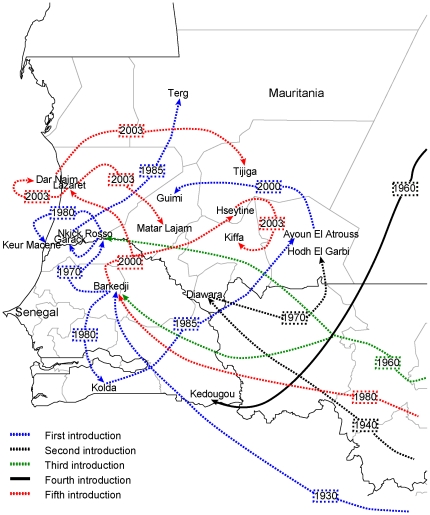
Geographic spread of RVFV in Mauritania and Senegal.The directed lines connect the sources and target localities (shown by arrows) of viral lineages. The distinct introductions into Senegal and Mauritania were represented by different colors. The estimated time to the most recent common ancestor of strains from different countries are shown within rectangles and could be interpreted as the oldest possible year of introduction of that lineage at that locality.